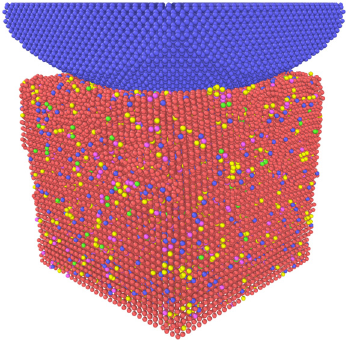
Figure 9. Snapshot of M50 bearing steel model when plastic deformation occurs.